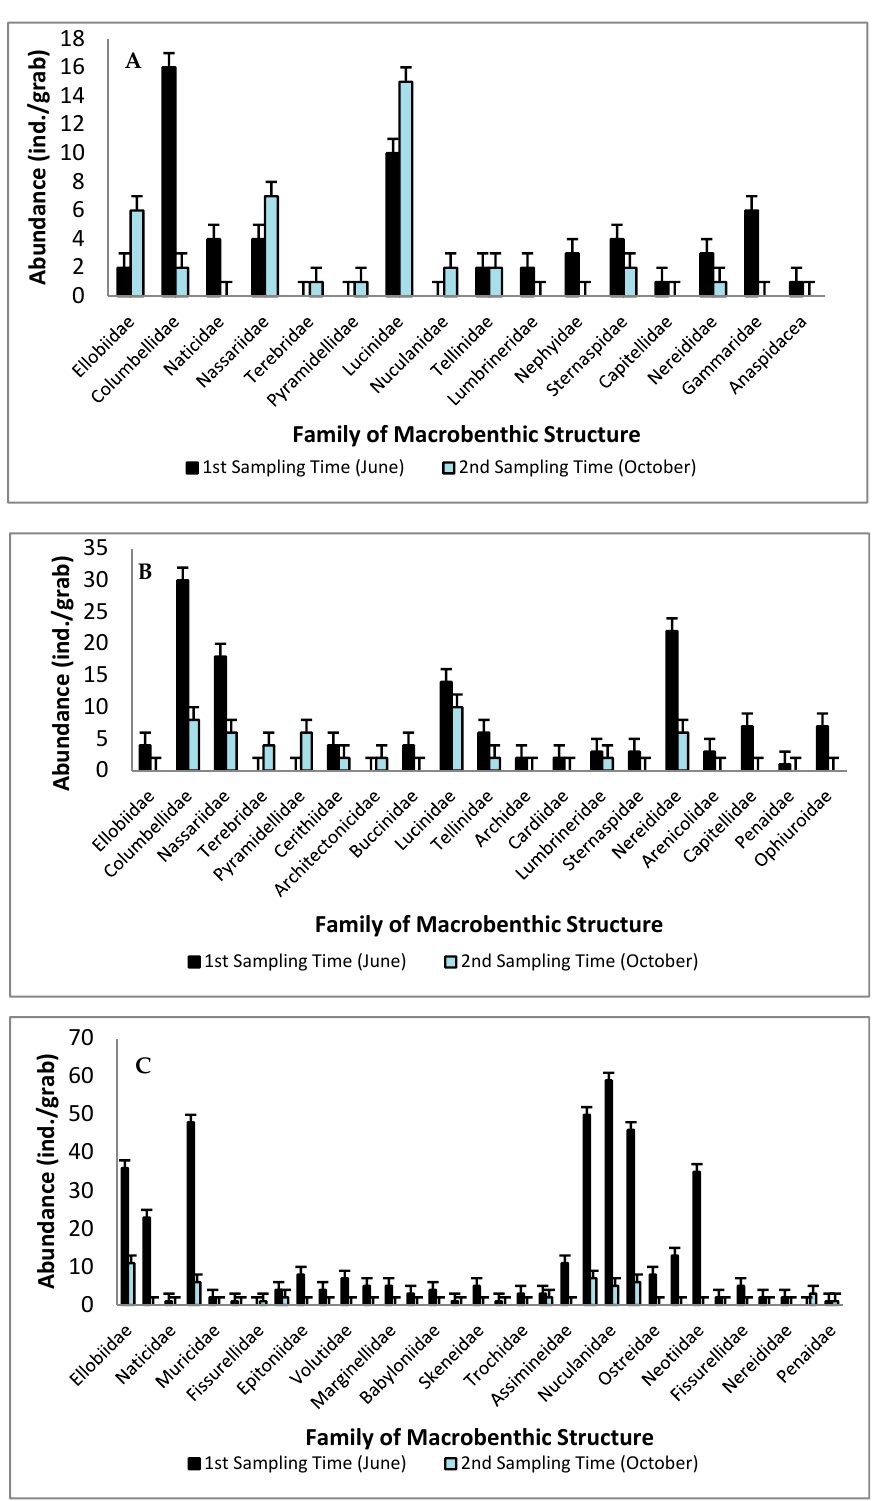
Figure 2. The structure of macrobenthos at ( A ) IMTA, ( B ) monoculture, and ( C ) reference site in different sampling time (±SD).